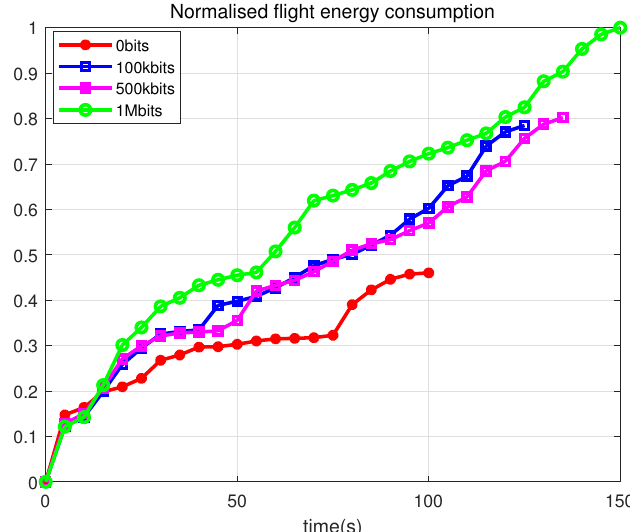
Figure 11. Normalized flight energy consumption.